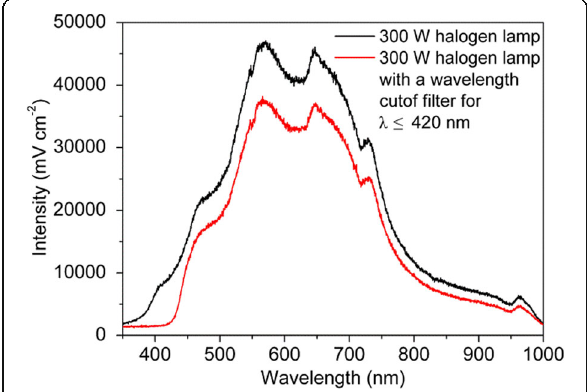
Fig. 1 Spectral distribution of the 300 W halogen lamp with and without optical